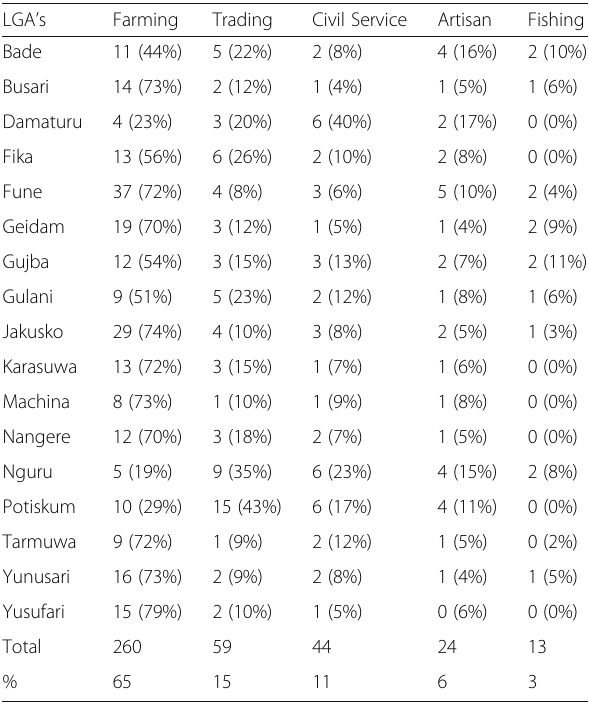
Table 5 Major economic activities of the respondents in the study area